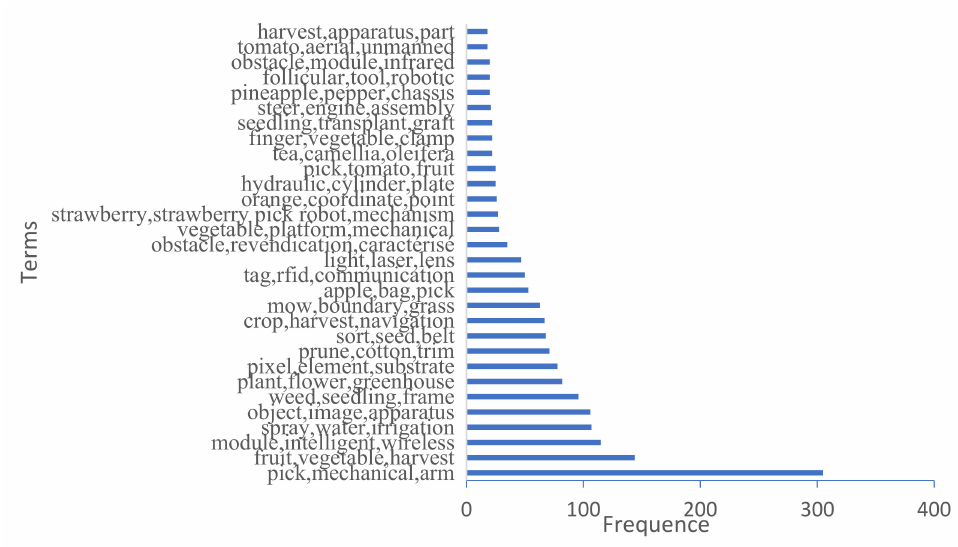
Figure 10. Keywords of recognition, detection, and location of agricultural robots.